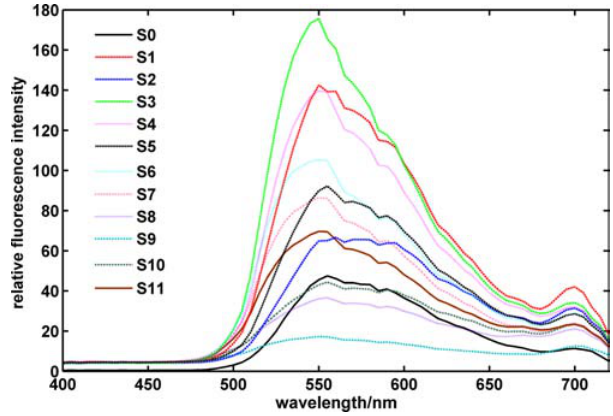
Fig. 7. The relative °uorescence intensity for the standard BH (S0) and the CPM samples (S1 – S11).